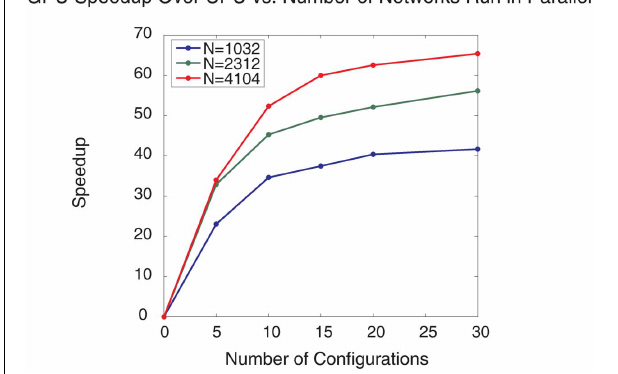
FIGURE 11 | Plot of GPU speedup over CPU vs. number of SNNs run in parallel for different sized SNNs and different numbers of SNNs run in parallel. Three different SNN sizes were used, the blue line denotes SNNs with 1032 neurons, the green line denotes SNNs with 2312 neurons, and the red line denotes SNNs with 4104